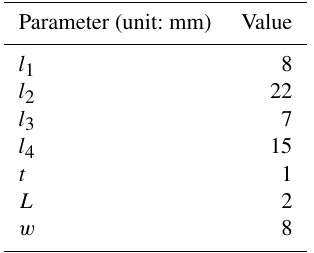
Figure 10. Optimization design of compliant mechanism based on flexible hinge. Table 1. Geometry of the compliant actuator based on